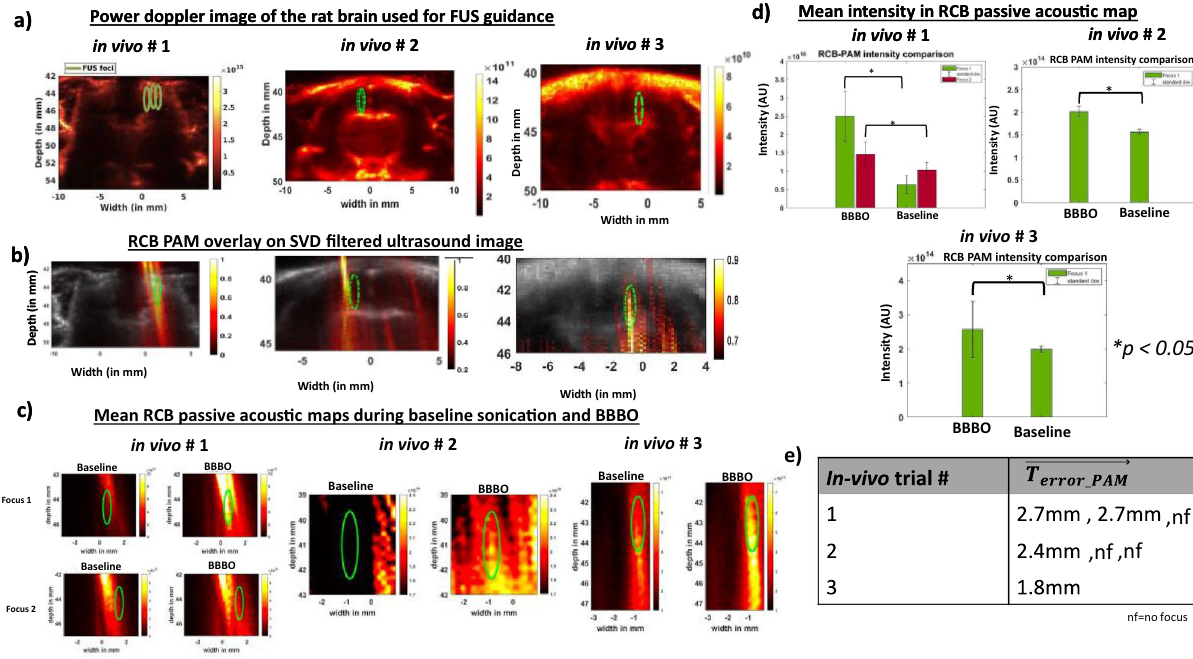
Figure 4. Power Doppler imaging can be used to guide BBB opening. ( a ) Power Doppler images from each in vivo case are shown with focal target overlaid in green. The first 2 trials have 3 foci and the third has a single focus applied as described in text. ( b ) RCB PAM, reconstructed from first 6.9 ms pulse just after MBs injection, overlayed on SVD filtered image show that PAM signals are present inside or near the intended FUS focus in first and third trials. ( c ) Cavitation maps show the relative difference between baseline and BBBO pulses during in vivo studies. ( d ) Mean RCB PAM intensity over 150 s reveal passive acoustic maps during BBBO have higher intensity than baseline maps for all maps that formed a focus in vivo. ( e ) Values of T_error PAM, computed from mean PAM maps constructed from first pulse of 150 s sonications for all three in vivo trials. Transmissions that did not form a focus on PAM maps (1/3 in trial 1 and 2/3 in trial 2 are denoted as